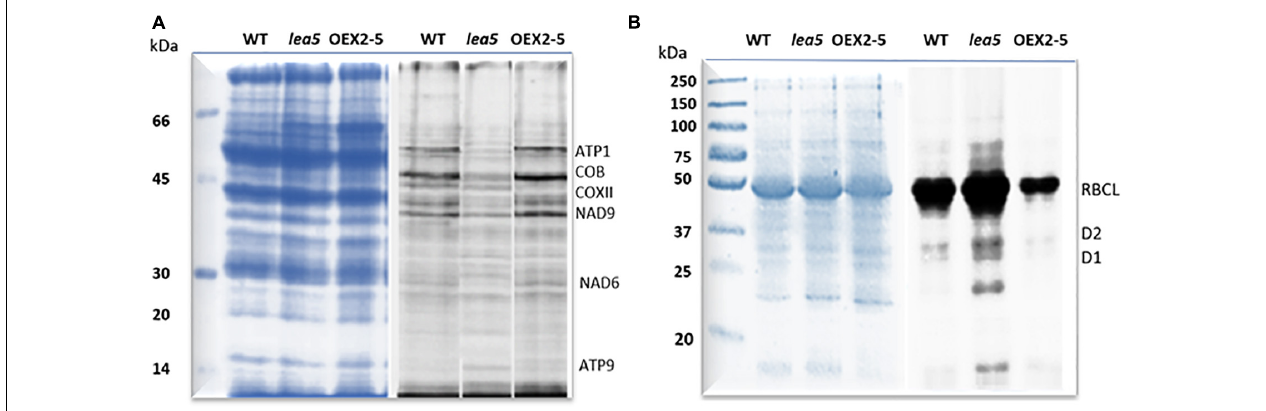
FIGURE 5 | A comparison of mitochondrial and chloroplast translation products in wild type (WT) Arabidopsis, a knockout line defective in LEA5 ( lea5 ) and a transformed Arabidopsis line overexpressing LEA5 (OEX2-5). Mitochondrial (A) and chloroplast proteins (B) were labeled with 35 S-Met. A shows the ATP synthase subunits, ATP1 and ATP9, the NADH:ubiquinone oxidoreductase (NAD) 7 and 9 subunits, cytochrome b (cob), and cytochrome c oxidase subunit II (COXII). (B) Shows labeling in the photosystem II reaction center proteins D1 and D2 proteins and the large subunit of ribuoose-1, 5-bisphosphate carboxylase oxygenase (RBCL).